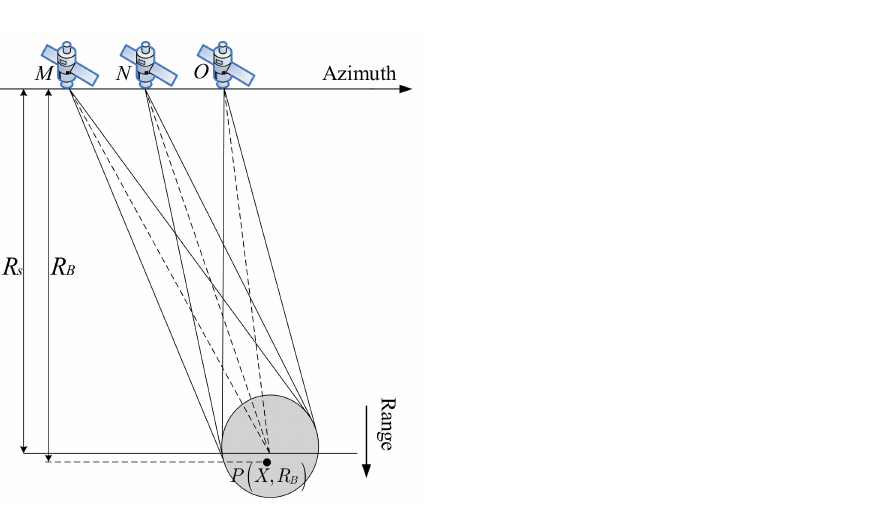
Figure 1. Geometric model of three transmitters and three receivers on